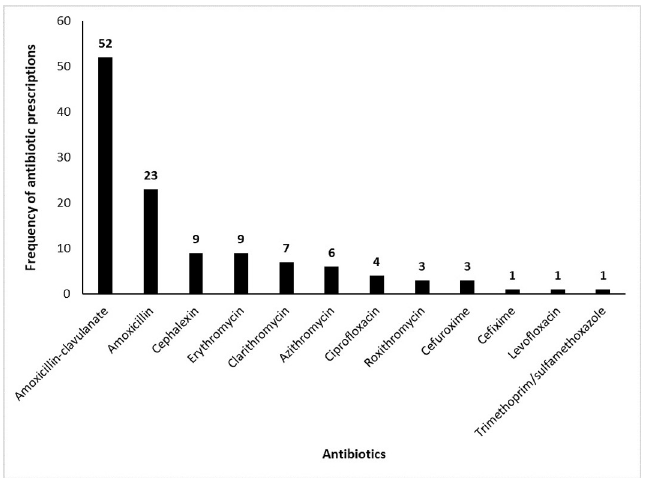
Fig 3. Types of antibiotics prescribed by GPs in this